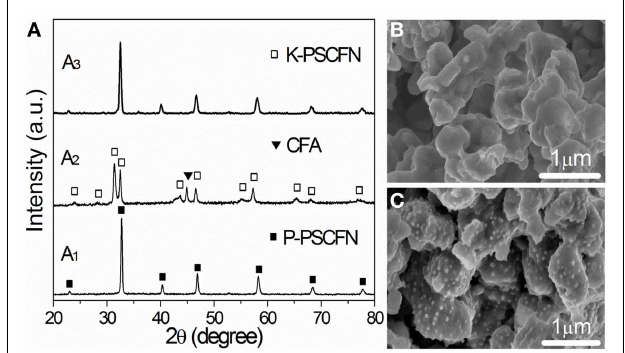
FIGURE 11 | (A) X-ray diffraction (XRD) patterns of (A1) R Pr 0.4 Sr 0.6 Co 0.2 Fe 0.7 Nb 0.1 O 3 sintered at 1050°C in air; (A2) Pr 0.4 Sr 0.6 Co 0.2 Fe 0.7 Nb 0.1 O 3 annealed in 5% H 2 –95% N 2 at 900°C; and (A3) Pr 0.4 Sr 0.6 Co 0.2 Fe 0.7 Nb 0.1 O 3 re-oxidized in air at 900°C; (B,C) SEM images of Pr 0.4 Sr 0.6 Co 0.2 Fe 0.7 Nb 0.1 O 3 before and after being reduced in H 2 at 900°C (Yang et al., 2012). Reprinted with permission from JohnWiley and